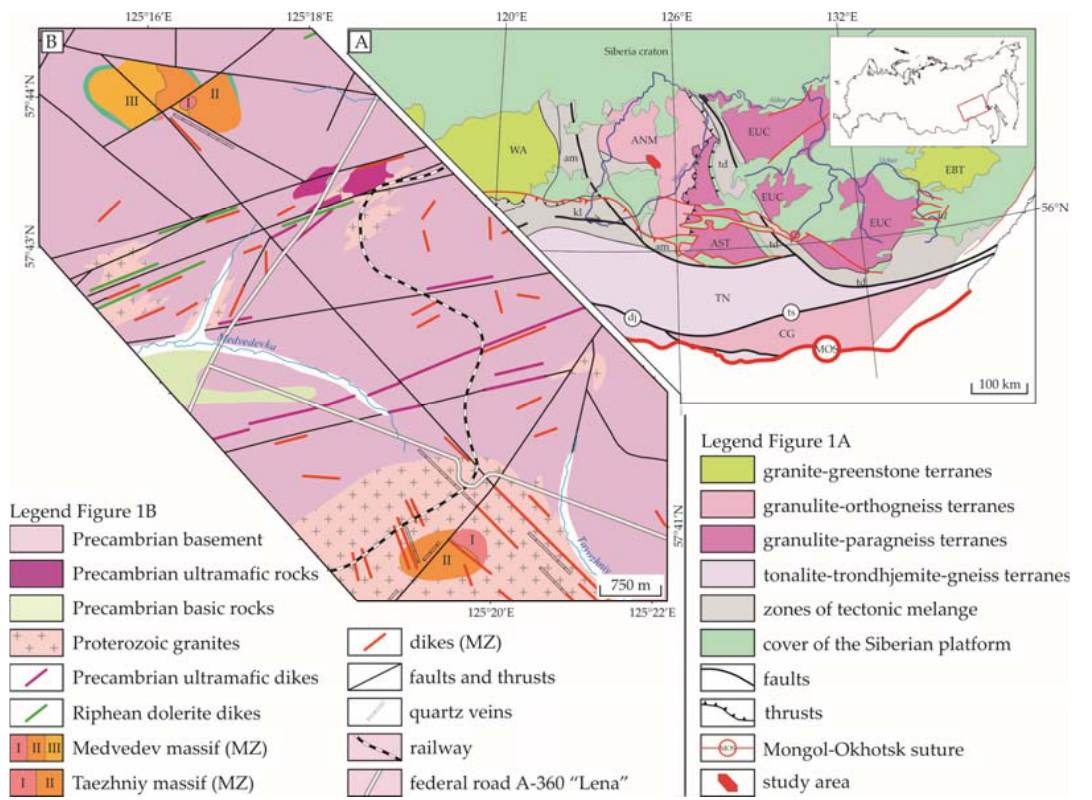
Figure 1. ( A ) Tectonic scheme of Aldan Shield [17]. Terranes: WA—West Aldan; EBT—Batomga; ANM—Nimnyr; CG—Chogar; AST—Sutam; EUC—Uchur; TN—Tyndin; zones of tectonic mélange: am—Amga, kl—Kalar, td—Tyrkanda; faults: dj—Dzheltulaksky, ts—Taksakandin. ( B ) Geological scheme of location of studied area (according to [18,26] with changes and additions of the